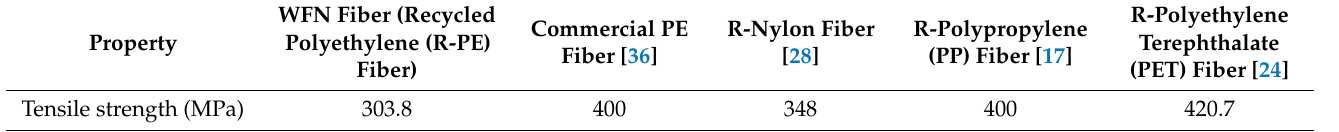
Table 2. Comparison of tensile strength of fibers in the present study and the